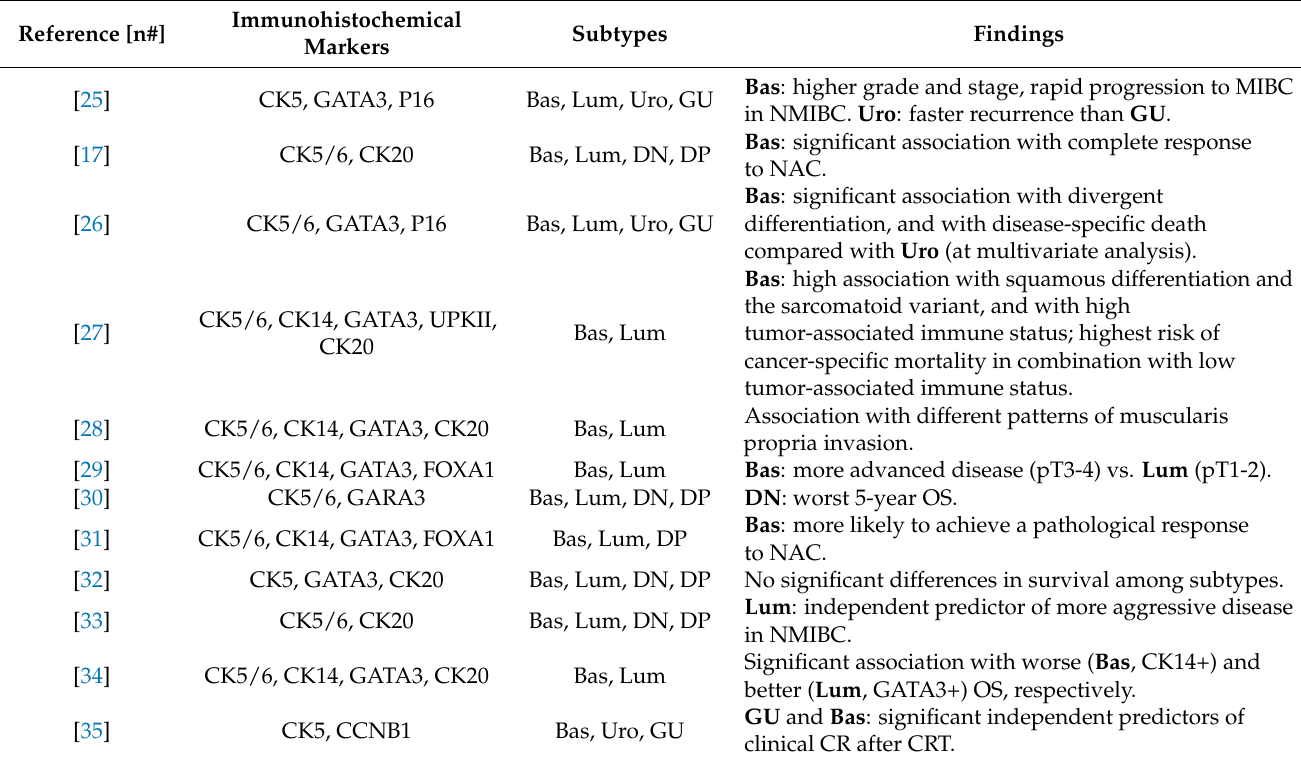
Table 1. Findings from selected studies assessing the prognostic/predictive role of IHC-based subtypes. Bas: basal-like; CR: complete response; CRT: chemoradiation therapy; DN: double negative; DP: double positive; GU: genomically unstable; Lum: luminal-like; MIBC: muscle invasive